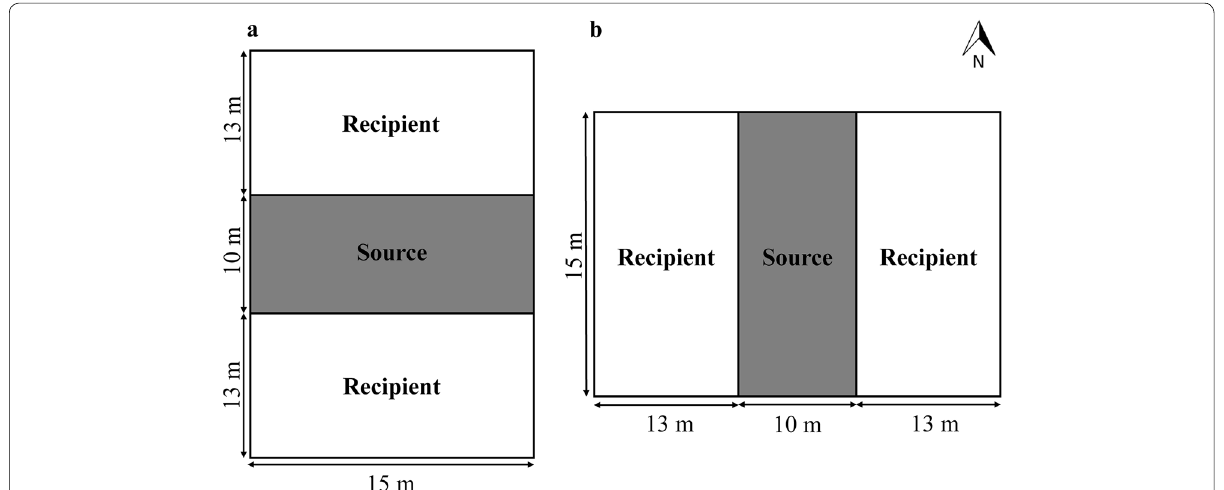
Fig. 1 Field design of experiment sites: a the Taiwan Agricultural Research Institute and b the Agricultural Experiment